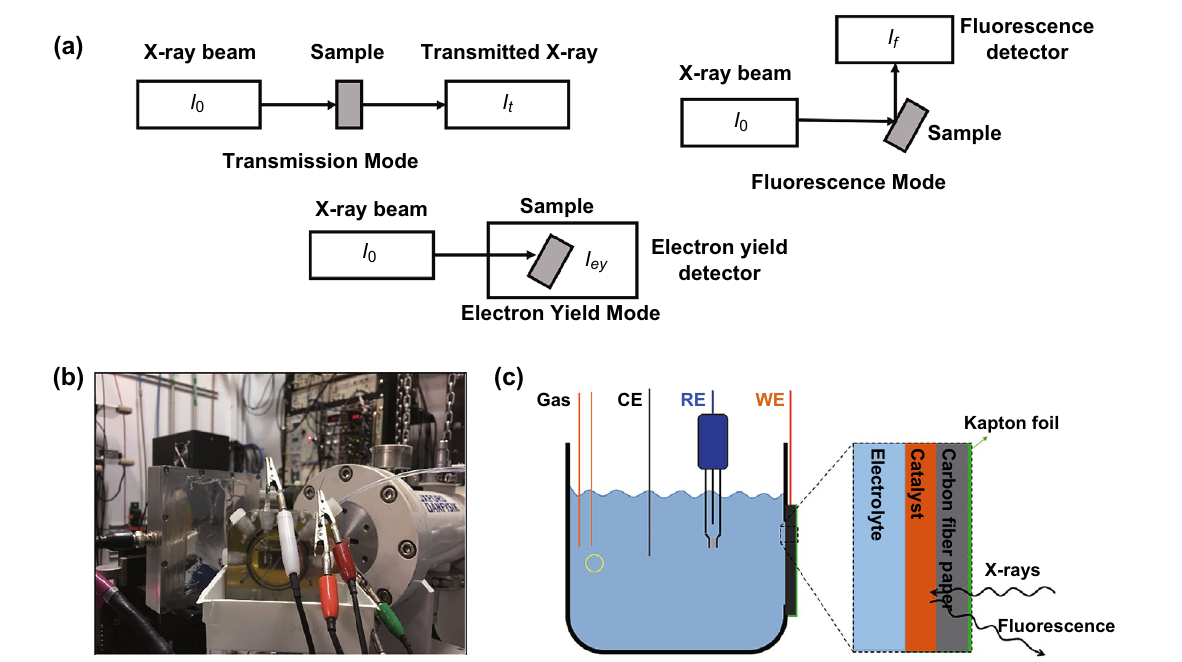
Fig. 2 a Schematic of the experiment setup for three different XAS detection modes: transmission, fluorescence, and electron yield mode. b Photo of a real electrochemical cell for in situ XAS experiment setup. c Schematic structure of the electrochemical cell for in situ XAS setup experiments. Reprinted with permission from Ref.